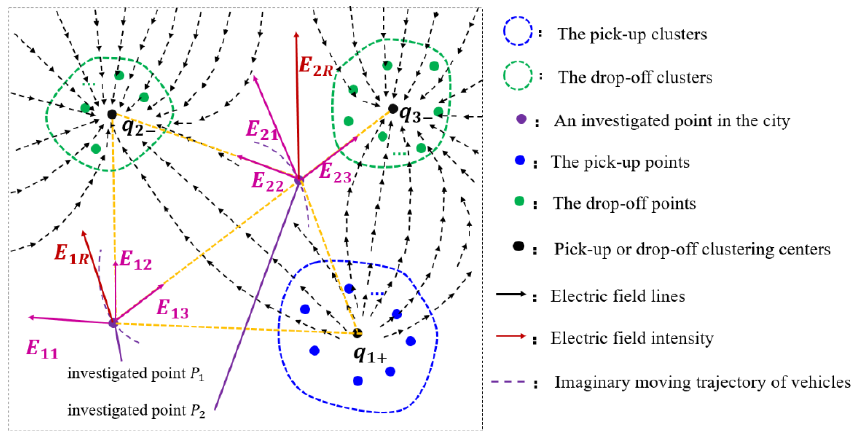
Figure 2. Graphic of the urban commuting electrostatics model. q i + ( − ) is the positive (negative) charge of cluster i , E jR is the electric field at road point j , and E ji is the electric field at road point j exerted by cluster i .